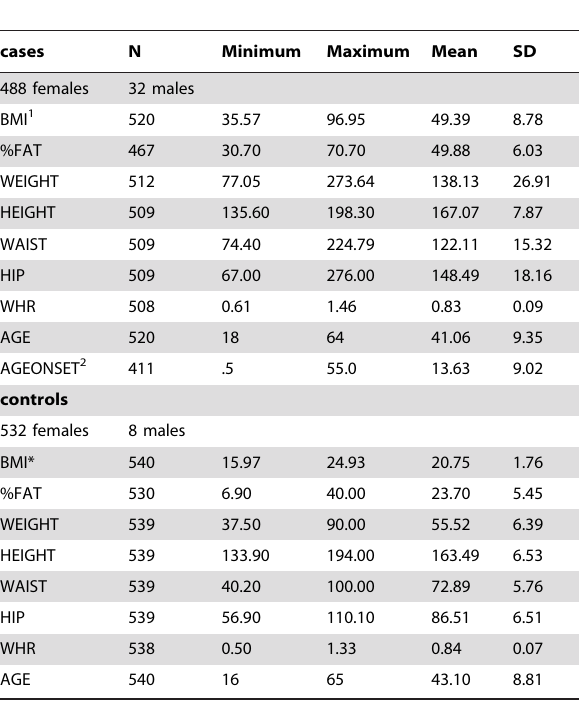
Table 1. Sample characteristics of 1,060 cases and controls in GWAS.